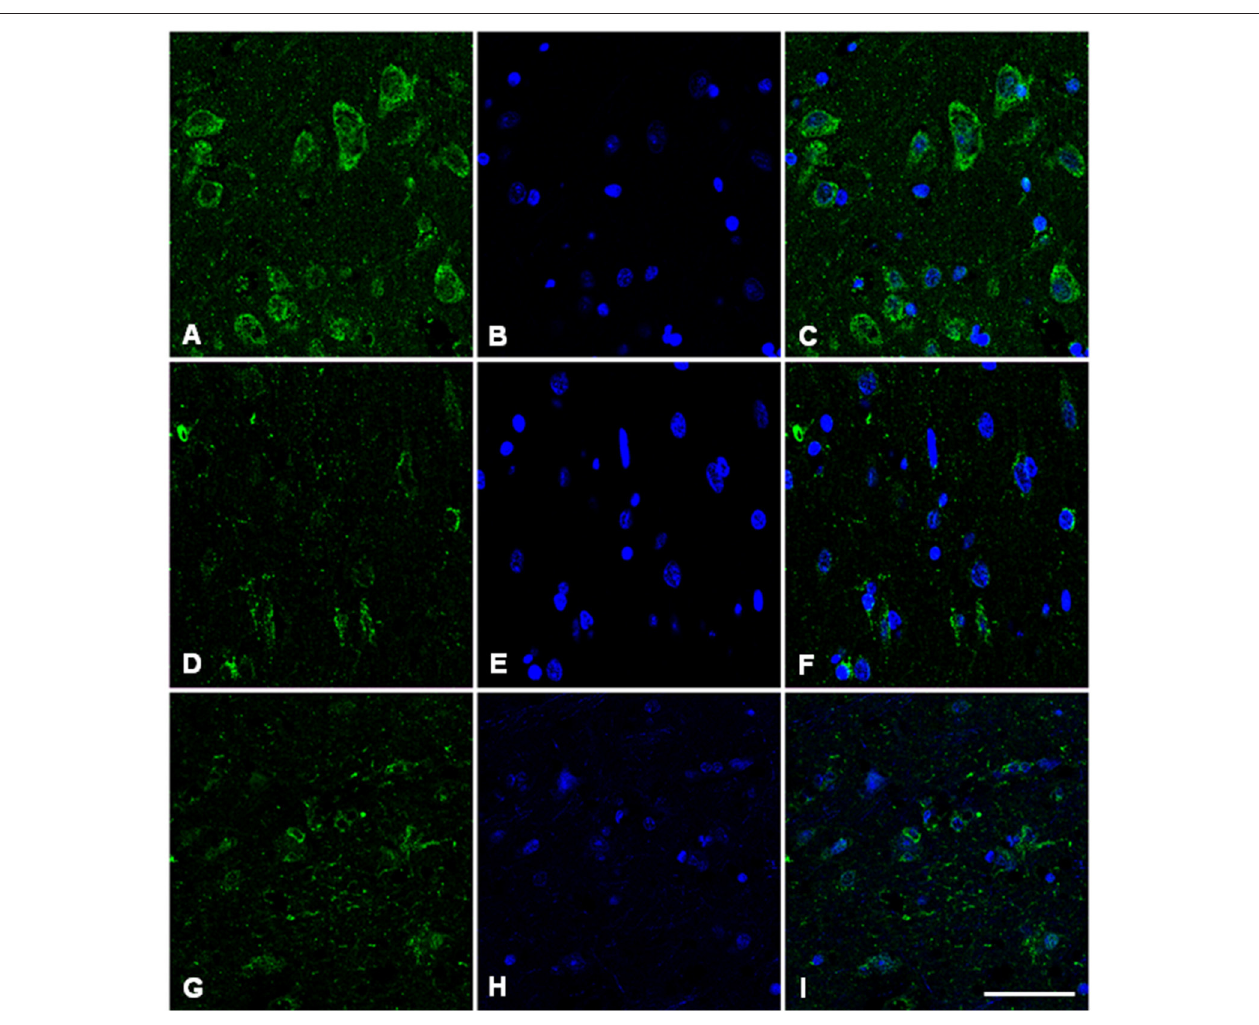
FIGURE 7 | Hemoglobin beta-chain in the frontal cortex of control subject (A–C) , Alzheimer’s disease (D–F) and sCJD (G–I). Immunofluorescence and confocal microscopy for hemoglobin B chain (A,D,G) and nuclei (B,E,H) showing reduced hemoglobin immunoreactivity in neurons of AD and sCJD (F, I merge) compared to control (C merge). Nuclei stained with DRAQ5 TM . Bar = 50 µ